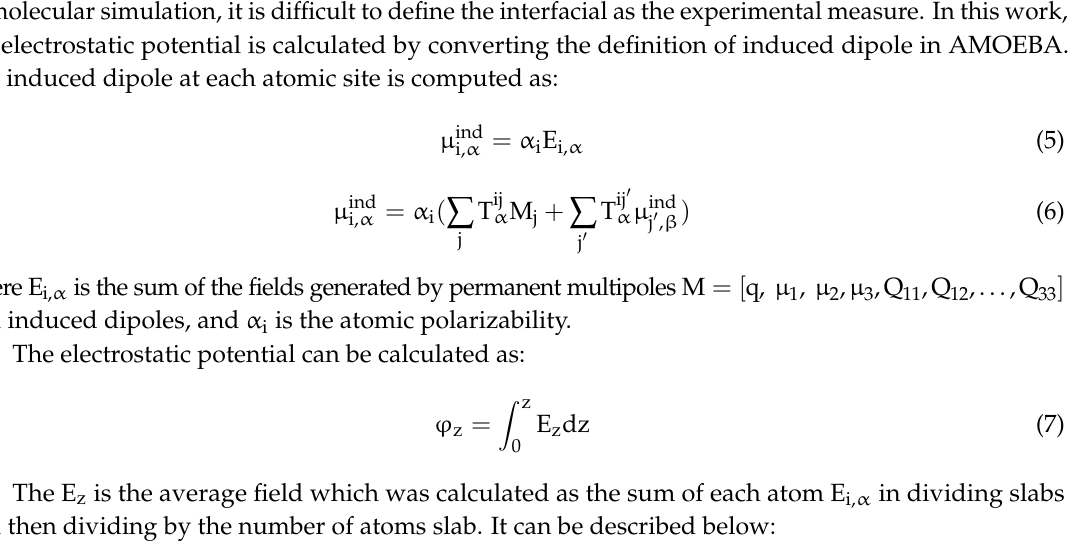
Figure 8. Probability distribution function of the angle between the lipid head P-N vector and the bilayer normal of the DOPC and POPE bilayer system from the last 20 ns.